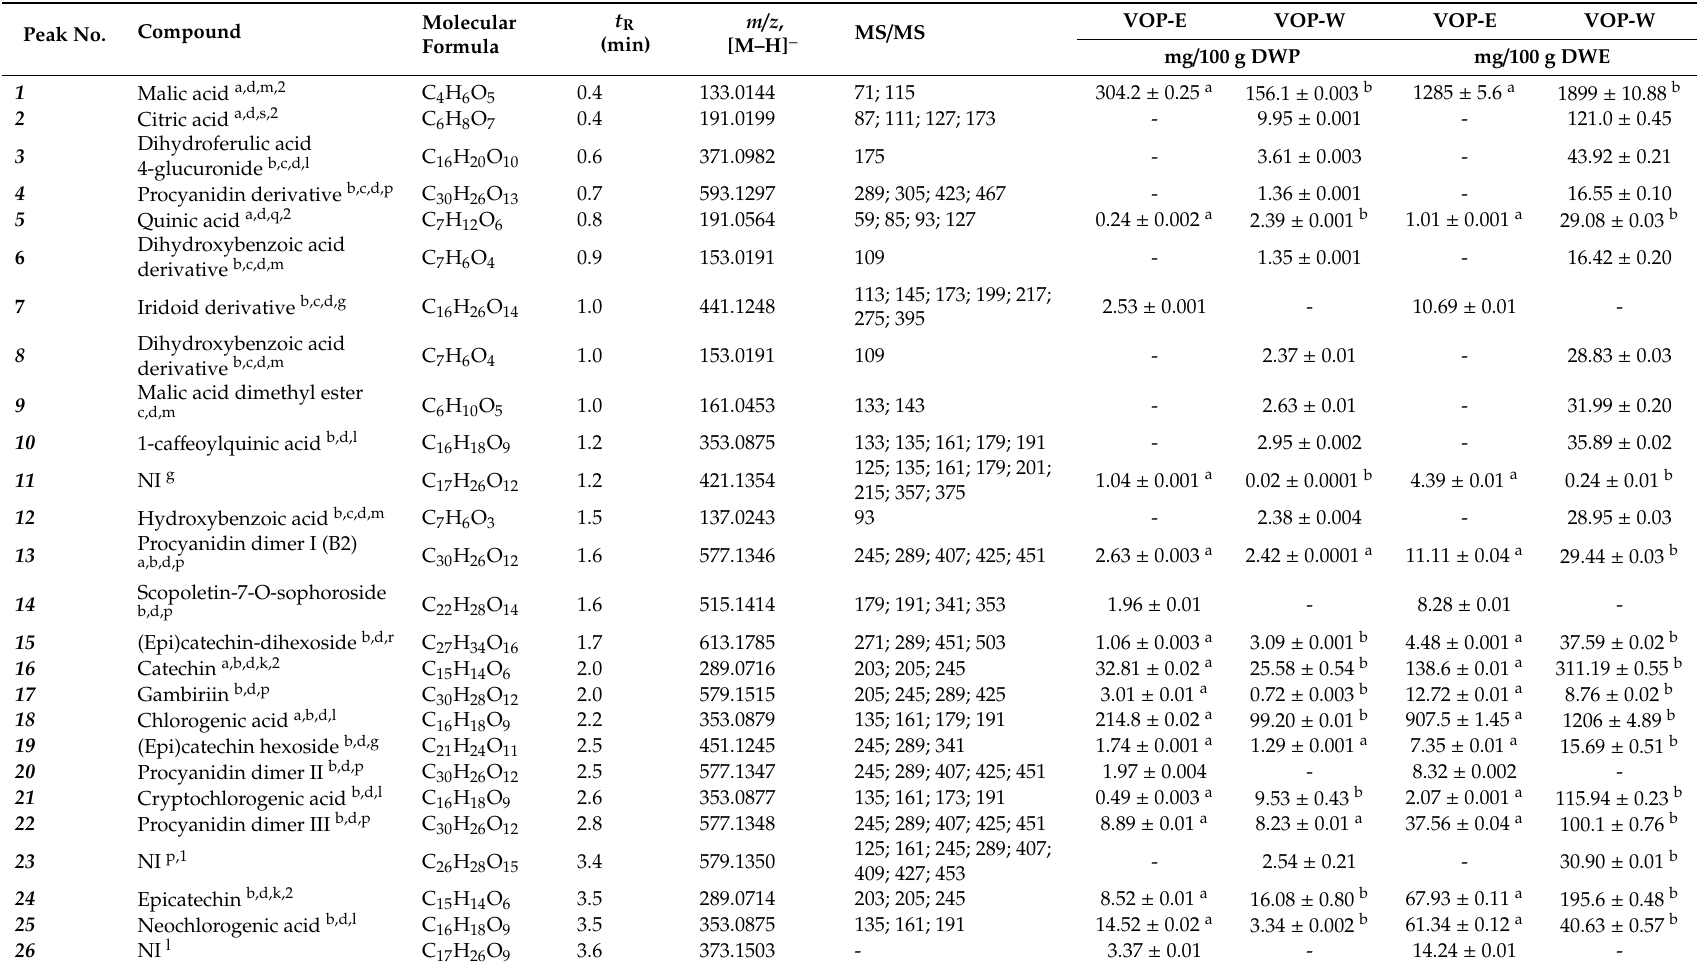
Table 2. Identification and quantification of individual phenolic compounds of guelder rose berry pomace extracts. Peak